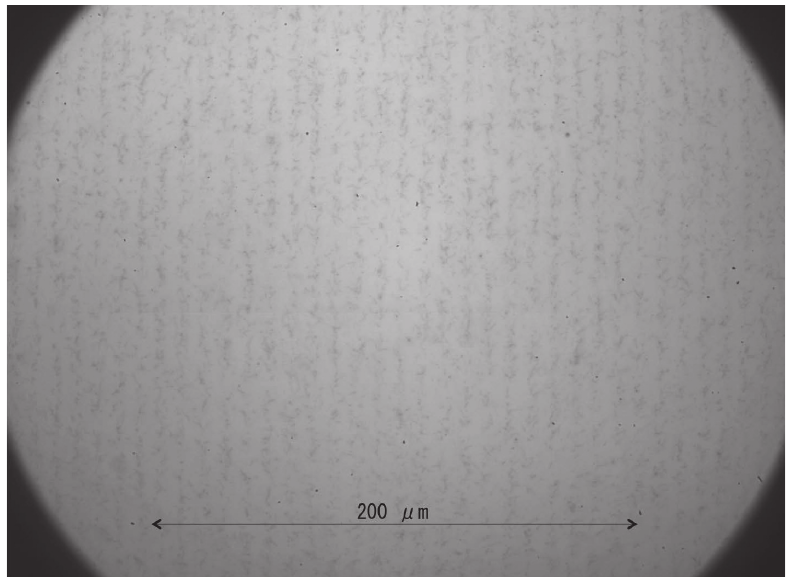
Figure 3. Neutron transmission image of the 9µm pitch Gd grating. The black vertical stripes show the track marks on emulsion. There are 22 vertical stripes in this 200µm area. These lines correspond to the grating pitch of 9µm.